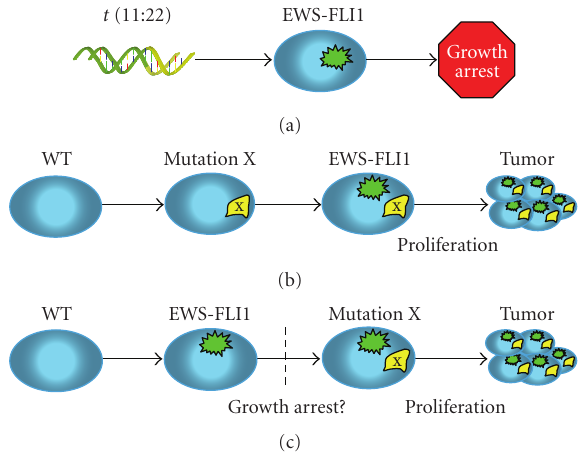
Figure 1: Cooperative mutations in the development of Ewing’s sarcoma. (a) A t(11;22) reciprocal translocation produces the EWS-FLI1 gene, but this tends to cause growth arrest in normal cells. (b) A mutation randomly occurring prior to the t(11;22) translocation might cooperate with EWS-FLI1 to permit escape from growth arrest (or even promote cell proliferation) and subsequent transformation to Ewing’s sarcoma. (c) The cooperative mutation may occur after the t(11;22) translocation; this would necessarily imply a mechanism for continued cell growth after EWS- FLI1 is expressed.